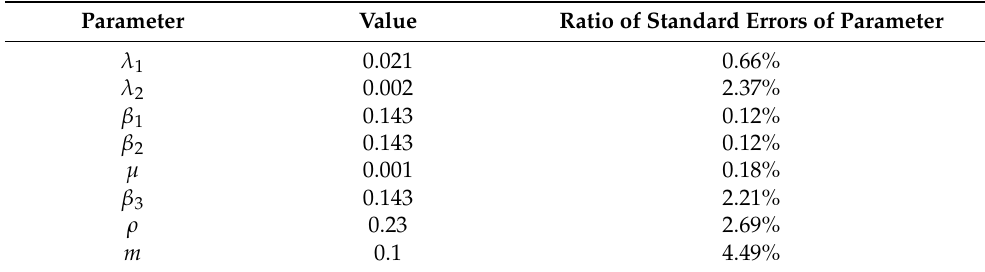
Table 8. Model estimated parameter values of stage 3. Parameter